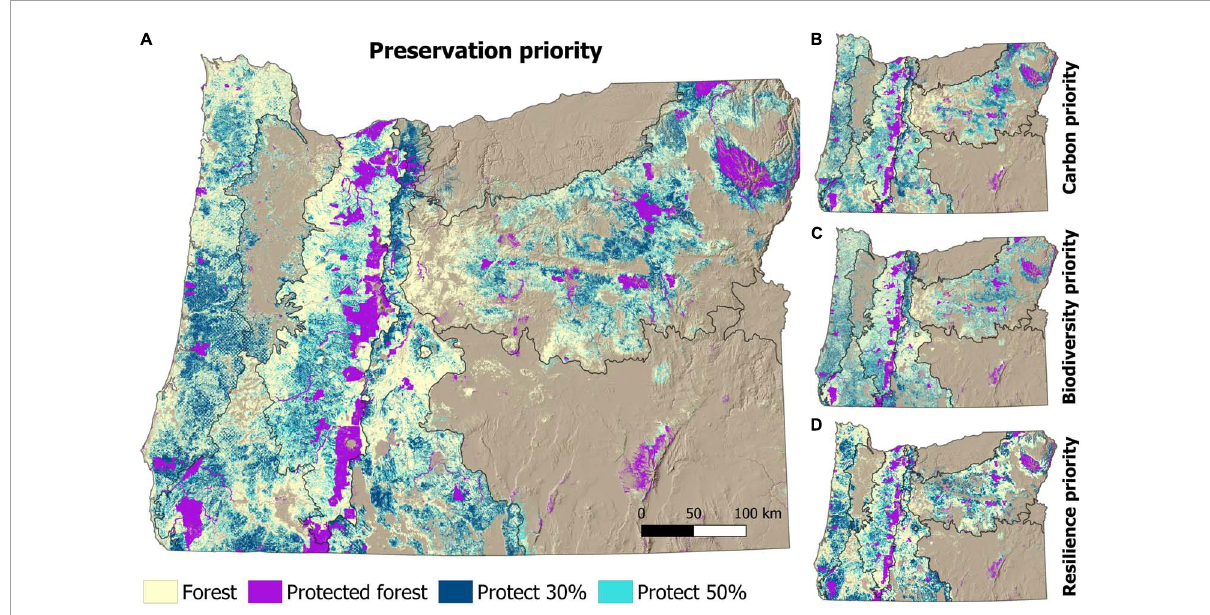
FIGURE3 Forestlands prioritized to meet preservation targets across Oregon. Preservation targets include protecting 30 and 50% of each ecoregion’s forestlands. To identify preservation targets, the current extent of forest protection was determined for each ecoregion and then the highest ranked unprotected forestlands were sequentially added to the protected area network until each preservation target was met. (A) Forest preservation priority targets are shown, as are the (B) carbon, (C) biodiversity, and (D) climate resilience priority